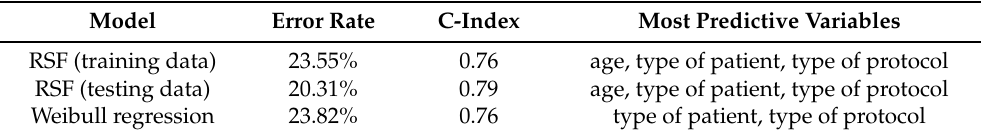
Table 9. Summary of the comparative study between the RSF and the Weibull regression